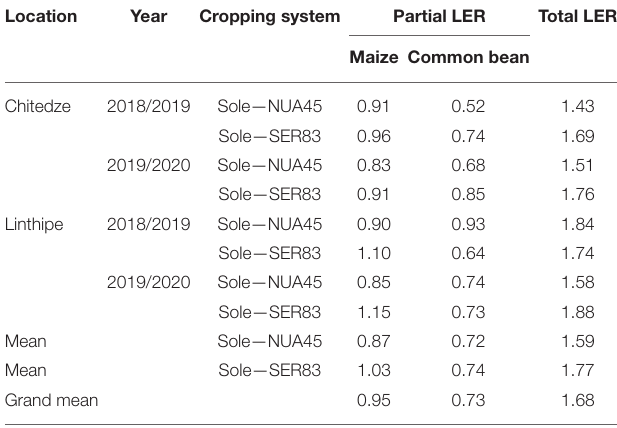
TABLE 7 | Simple t -test of total land equivalent ratio (LER) from intercropping a maize variety with two common bean varieties NUA45 and SER83 at Chitedze and Linthipe in 2019 and